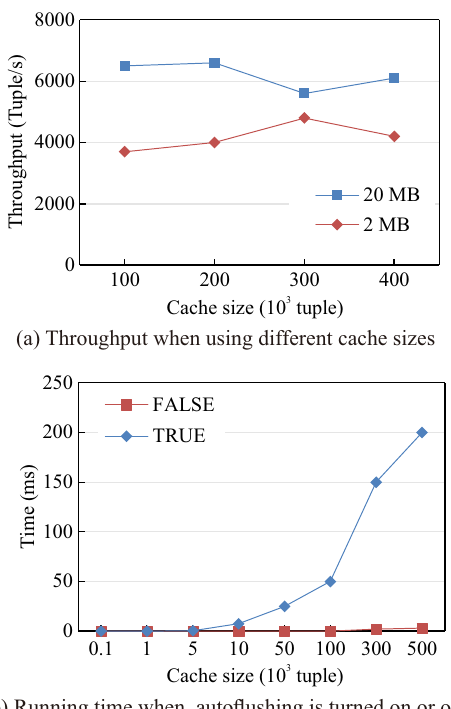
Fig. 17 Effects of region sizes. Fig. 18 Effects of cache size and automatic